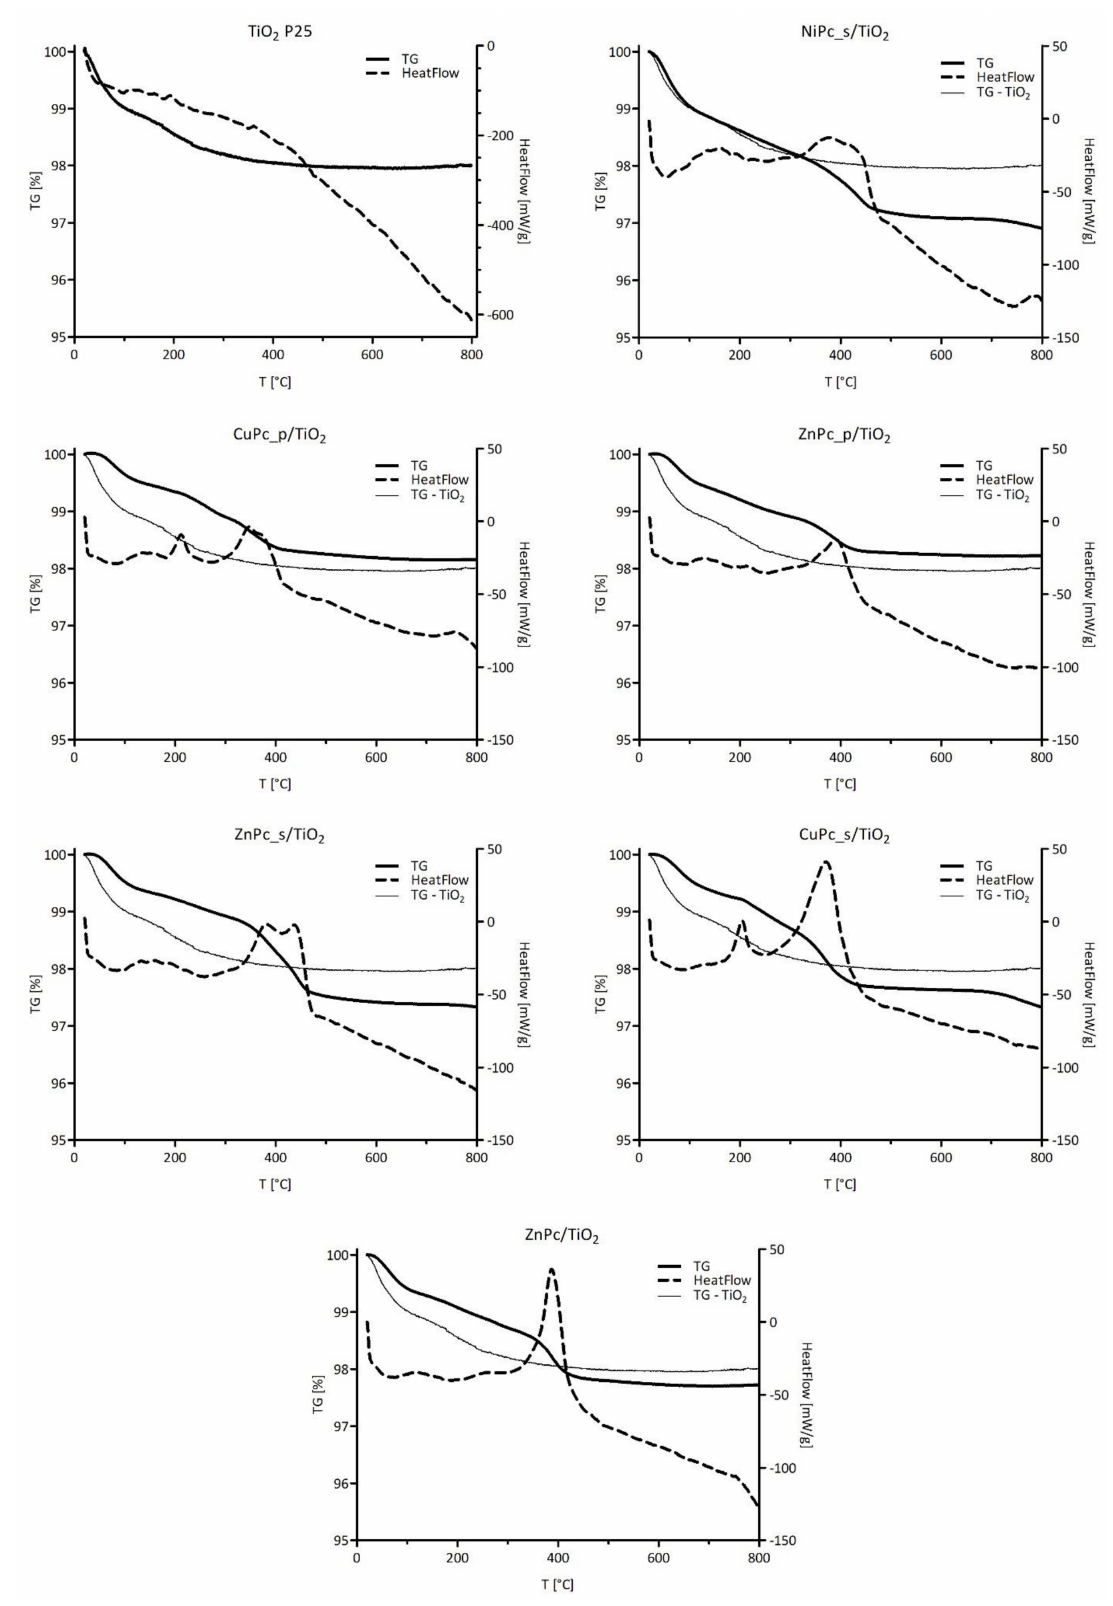
Figure 10. TG–DSC of prepared photocatalytic composites: TG and HeatFlow